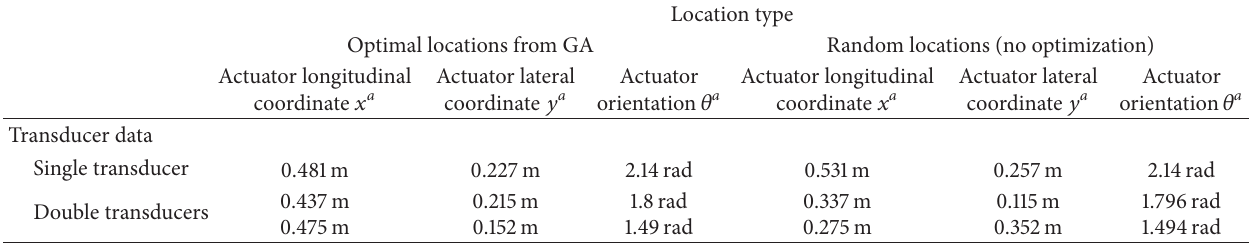
Table 9: GA-optimal and random configurations of piezoelectric transducers attached to the rectangular plate. The first three modes are the dominant modes, while the next two modes are the residual